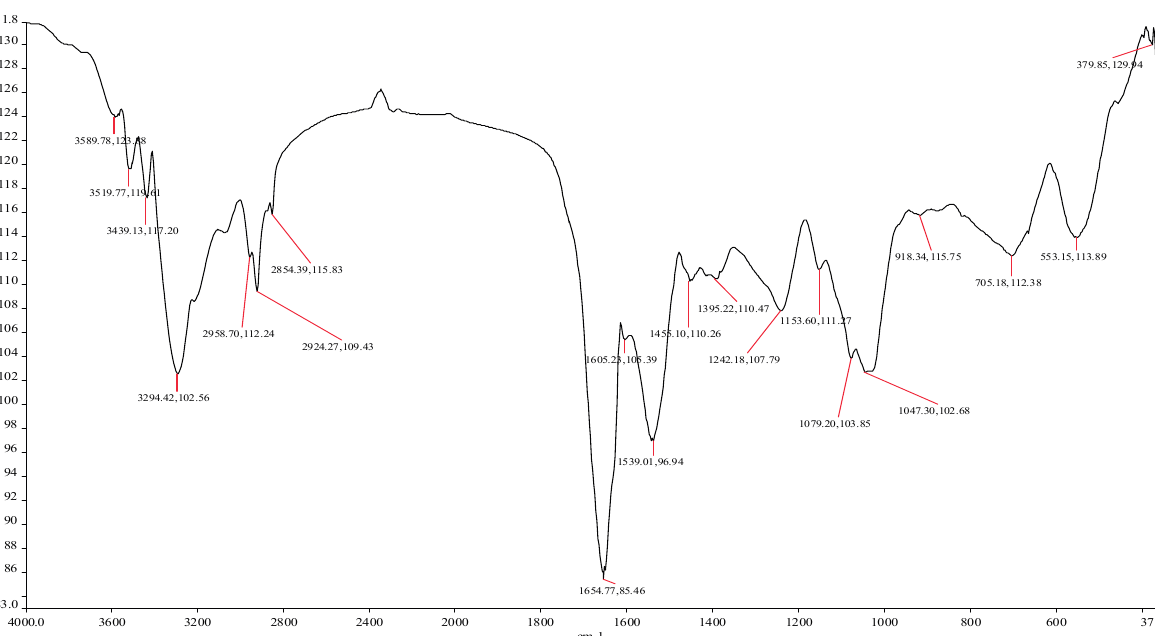
Figure 3. FTIR spectrum of purified bioflocculant from mixed culture fermentation of Brachybacterium sp. UFH and Streptomyces sp.